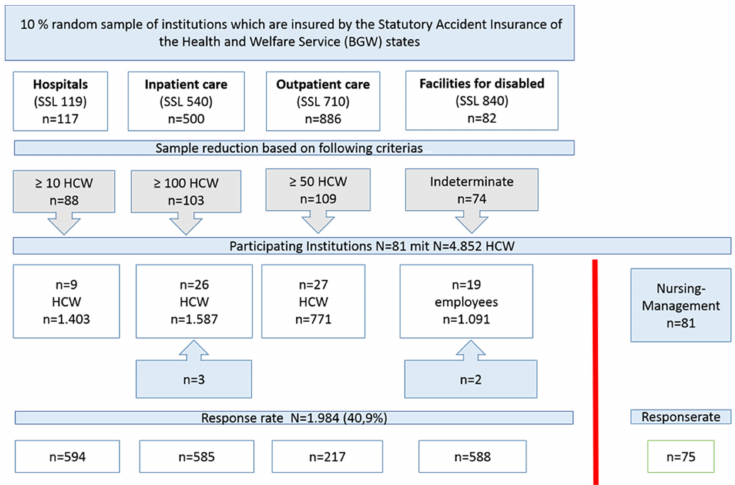
Figure 1. Flow chart study